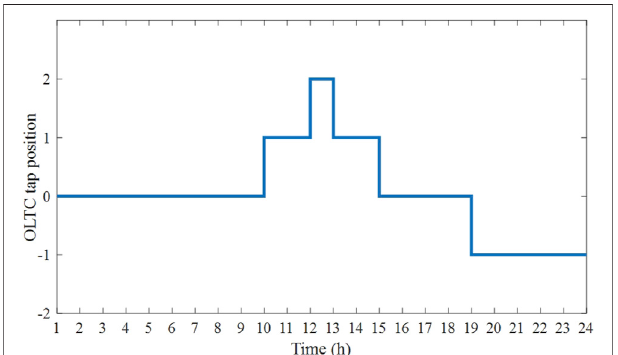
FIGURE 8 | Tap positions of OLTC.